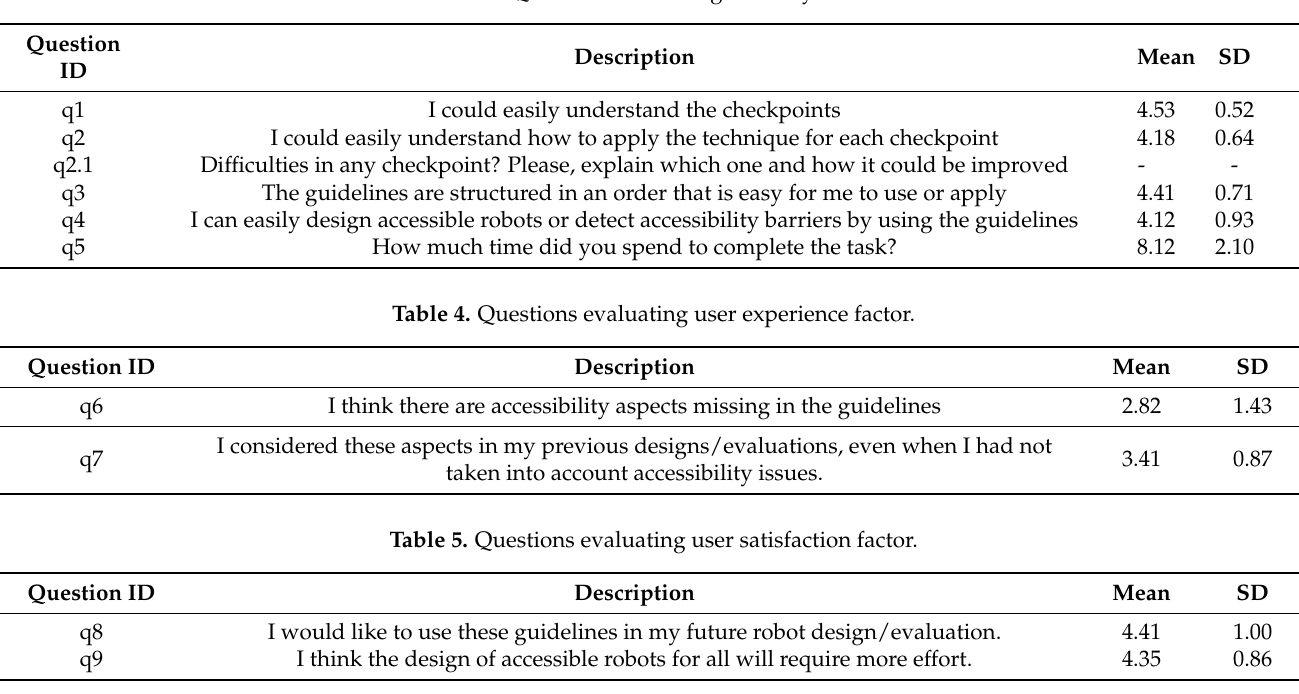
Table 3. Questions evaluating usability factor.